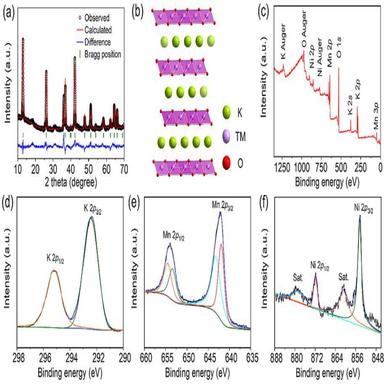
(a) Rietveld refinement of XRD data, (b) crystal structure, (c) XPS survey spectrum, (d) high-resolution K 2p XPS spectrum, (e) high-resolution Mn 2p XPS spectrum, and (f) high-resolution Ni 2p XPS spectrum of the KMNO cocoons.